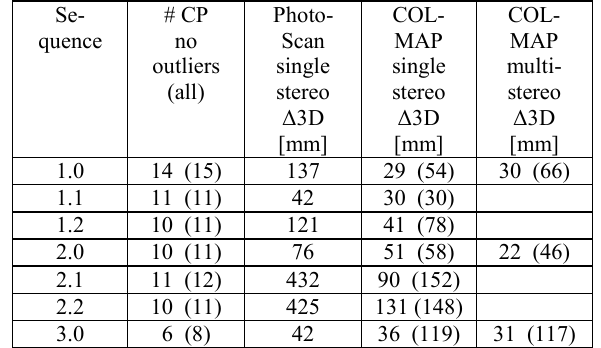
Table 2. RMSE values for check point (CP) residuals between image-based georeferencing and tachymetry (results from all observations, including outliers are shown in brackets) The obtained mean RMSE values for check point residuals of 58 mm for all forward image sequences and 28 mm for multi-stereo sequences lie in the range of the GCP residuals. When processing image sequences of trajectories with sharp curves, 3D points cannot be tracked in so many images as in nearly straight segments, hence deteriorating the accuracy. Especially in such cases, multi-stereo images from opposite driving directions are beneficial since even images from the back-right and left stereo systems can be matched leading to a more precise co-registration.